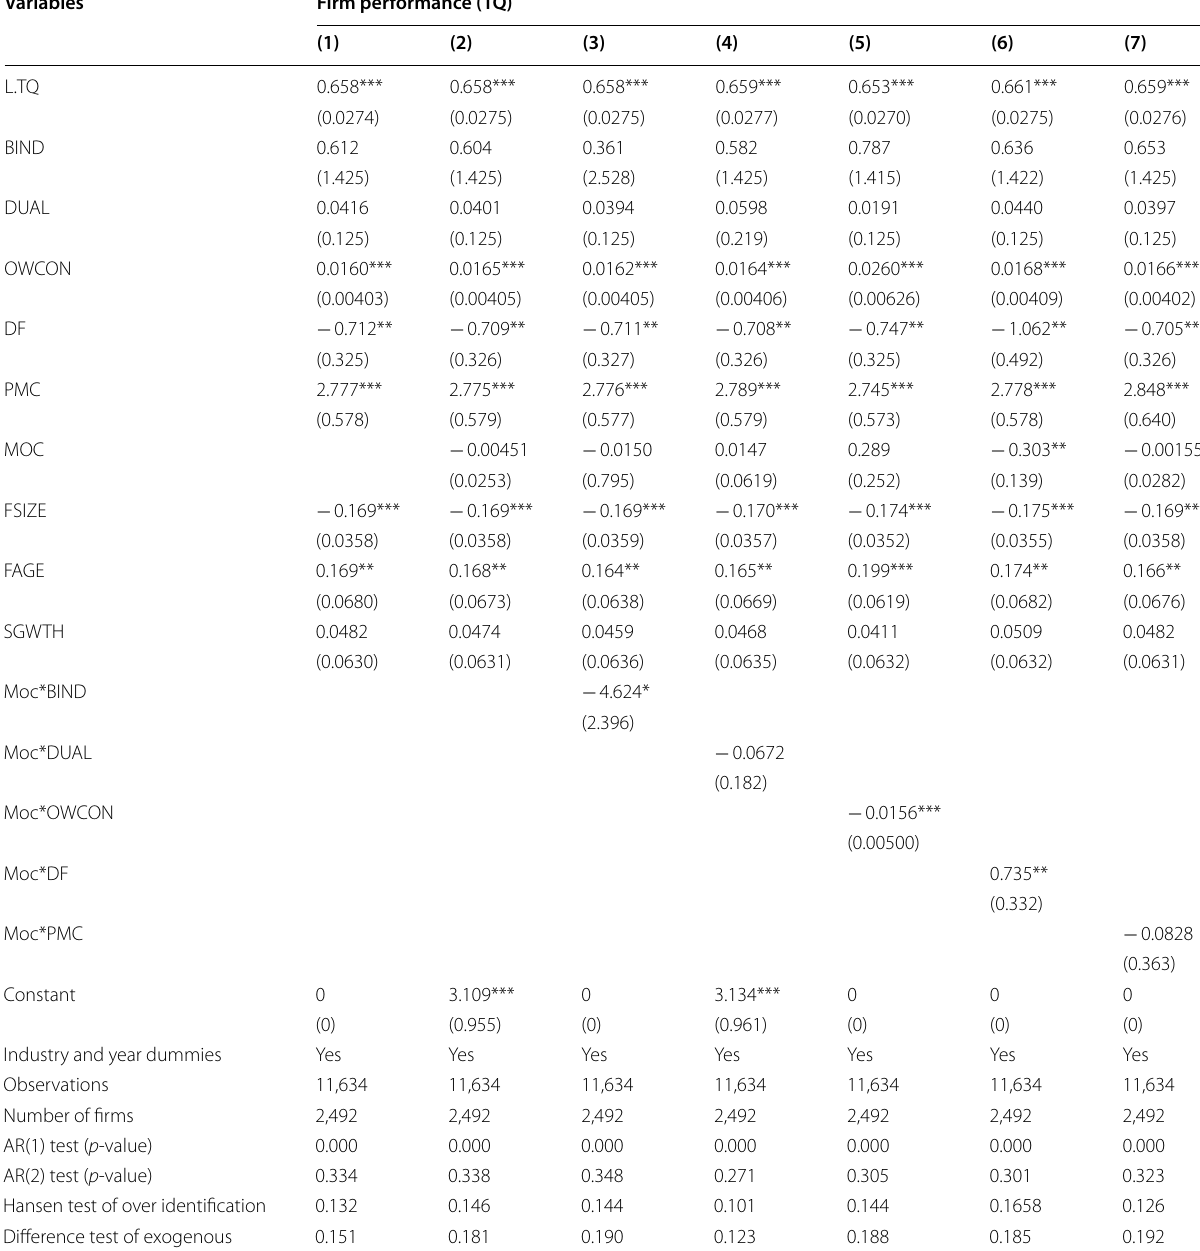
Table 4 Regression results of influencing role of managerial overconfidence in the relationship of corporate governance mechanisms and firm performance